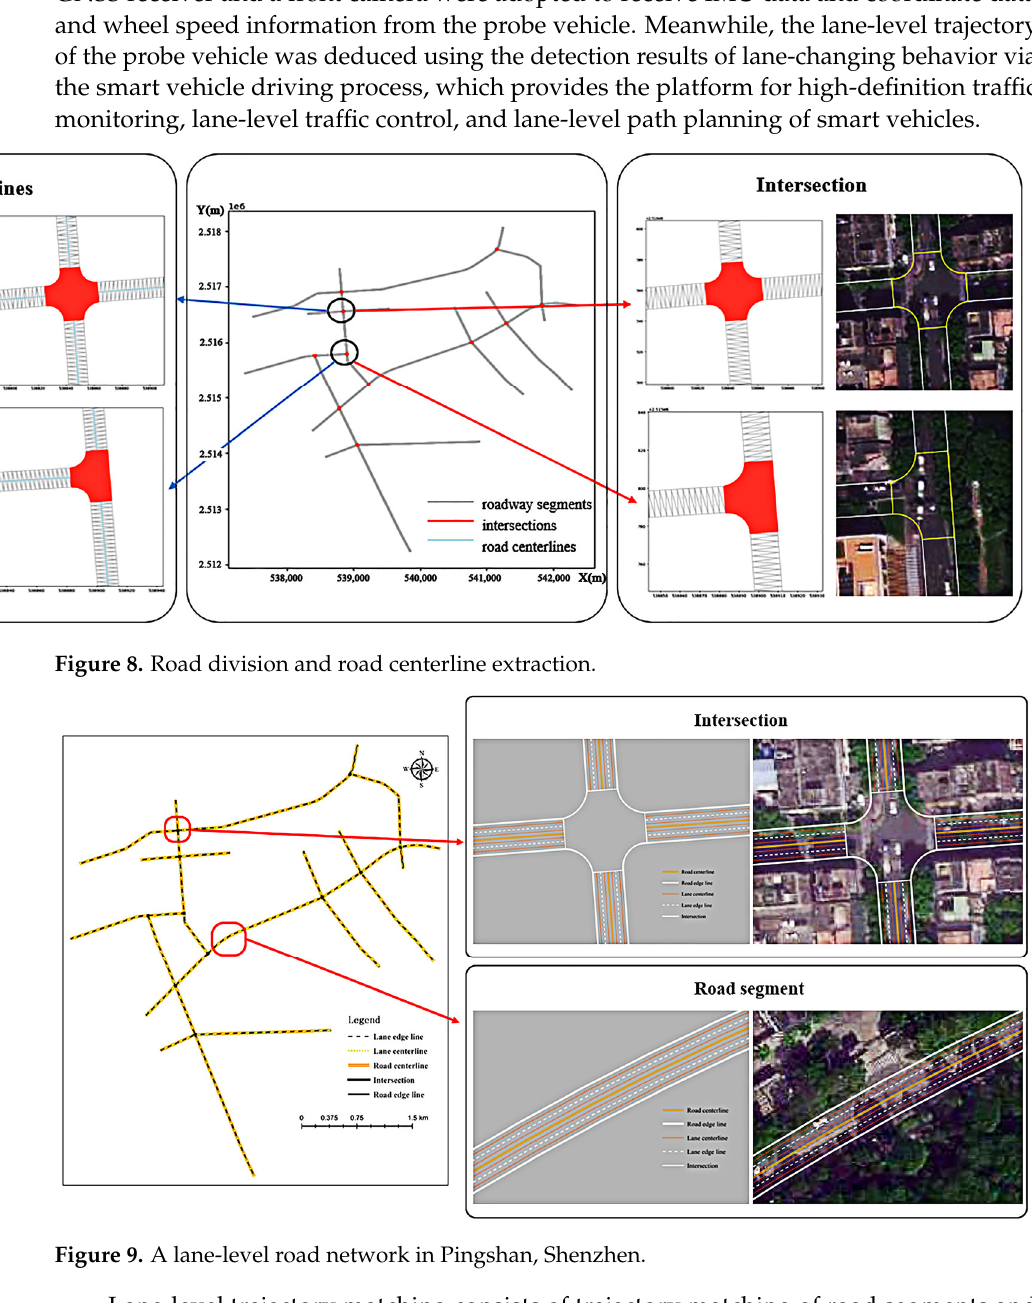
Figure 9. A lane-level road network in Pingshan, Shenzhen.